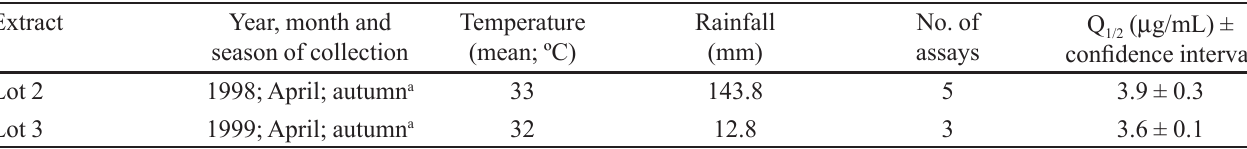
TABLE I - Antioxidant activity in vitro (inhibition of 50% of spontaneous lipoperoxidation: Q from Heteropterys aphrodisiaca Extract Year, month